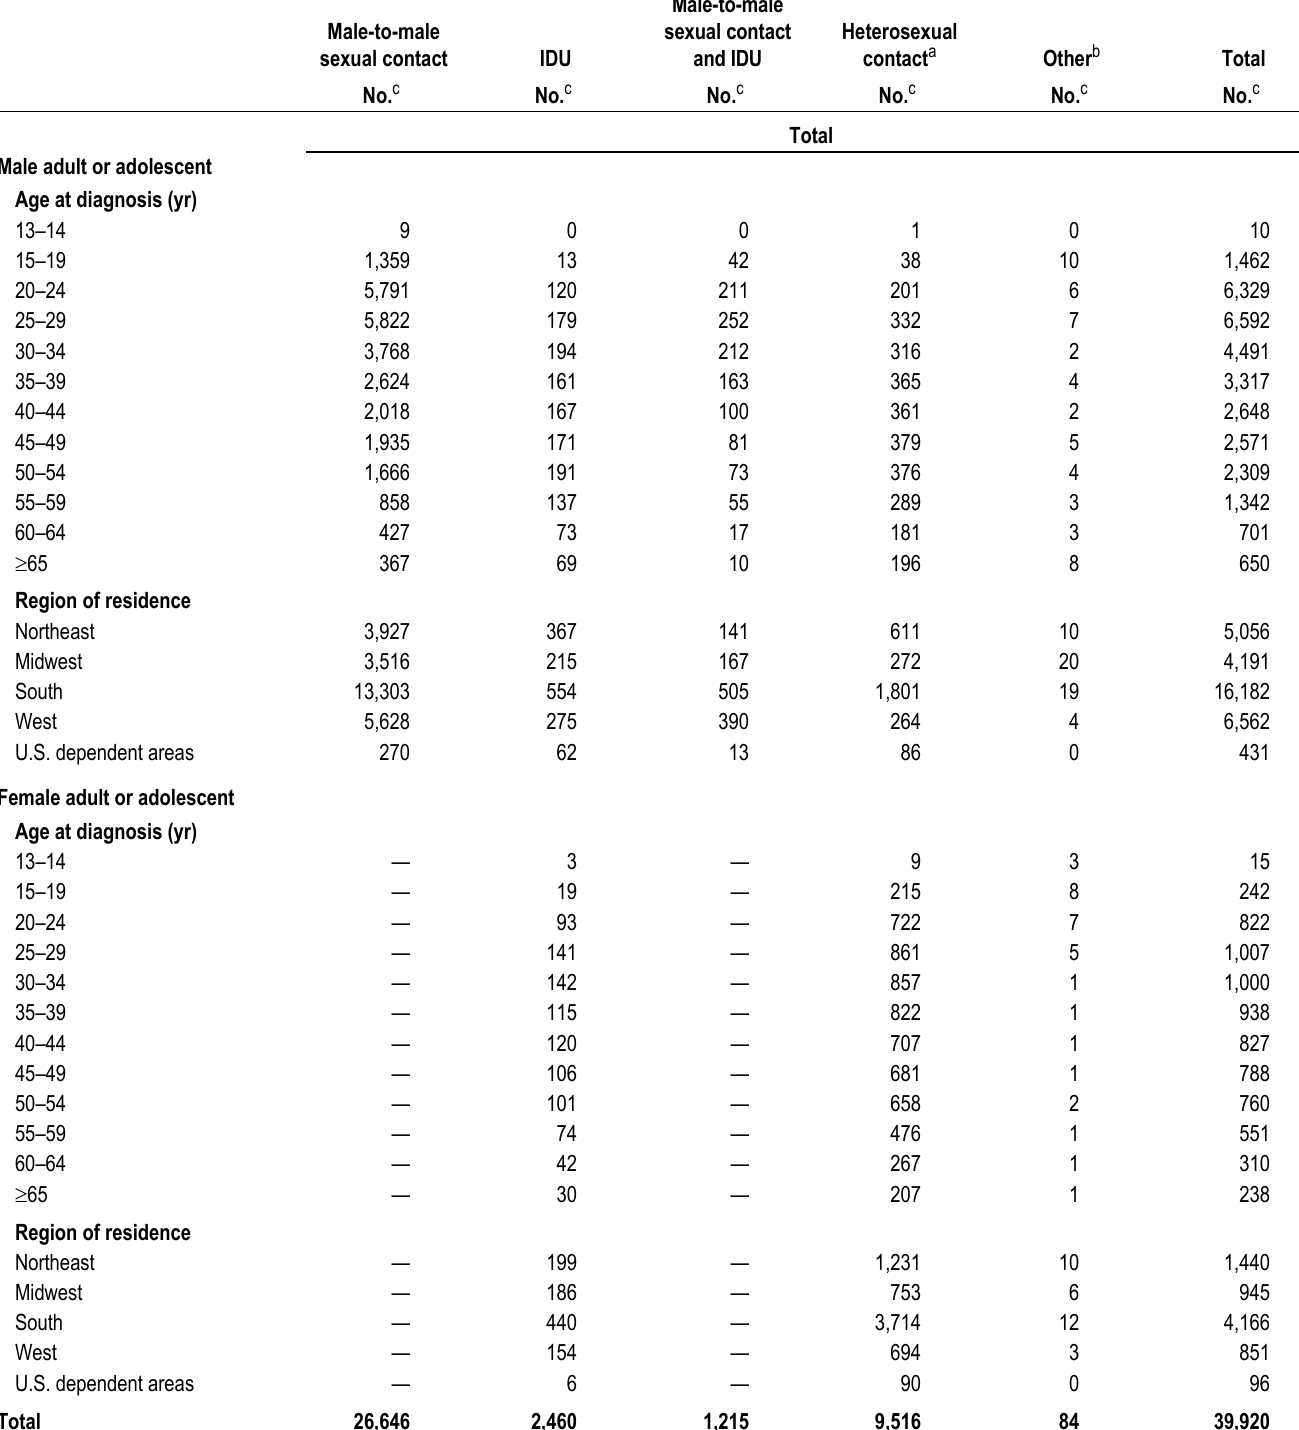
Table 5b. Diagnoses of HIV infection, by transmission category, race/ethnicity, and selected characteristics, 2015—United States and 6 dependent areas